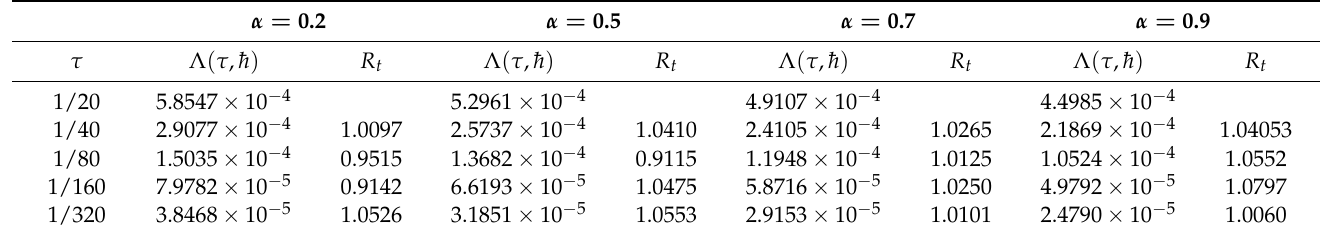
Table 2. The error and convergence rate when ¯ h = 0.02 and β = 1.9, T = 1. α = 0.2 α = 0.5 α = 0.7 α =